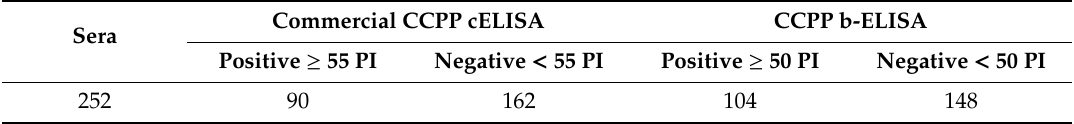
Table 2. Comparative test results for the commercial CCPP competitive ELISA (cELISA) and CCPP b-ELISA. The PI cut-off values for the CCPP cELISA and CCPP b-ELISA were 55 and 50, respectively.